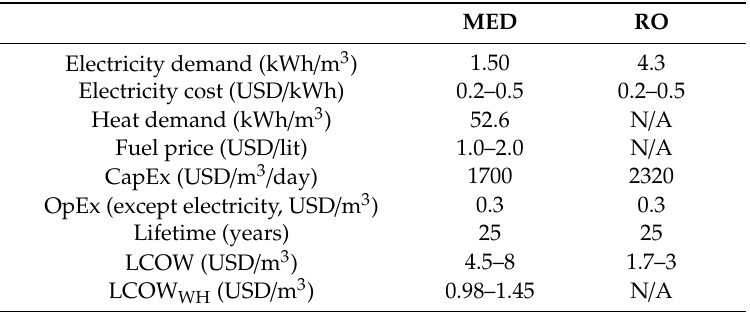
Table 2. Input variables for the LCOW evaluation of MED and RO